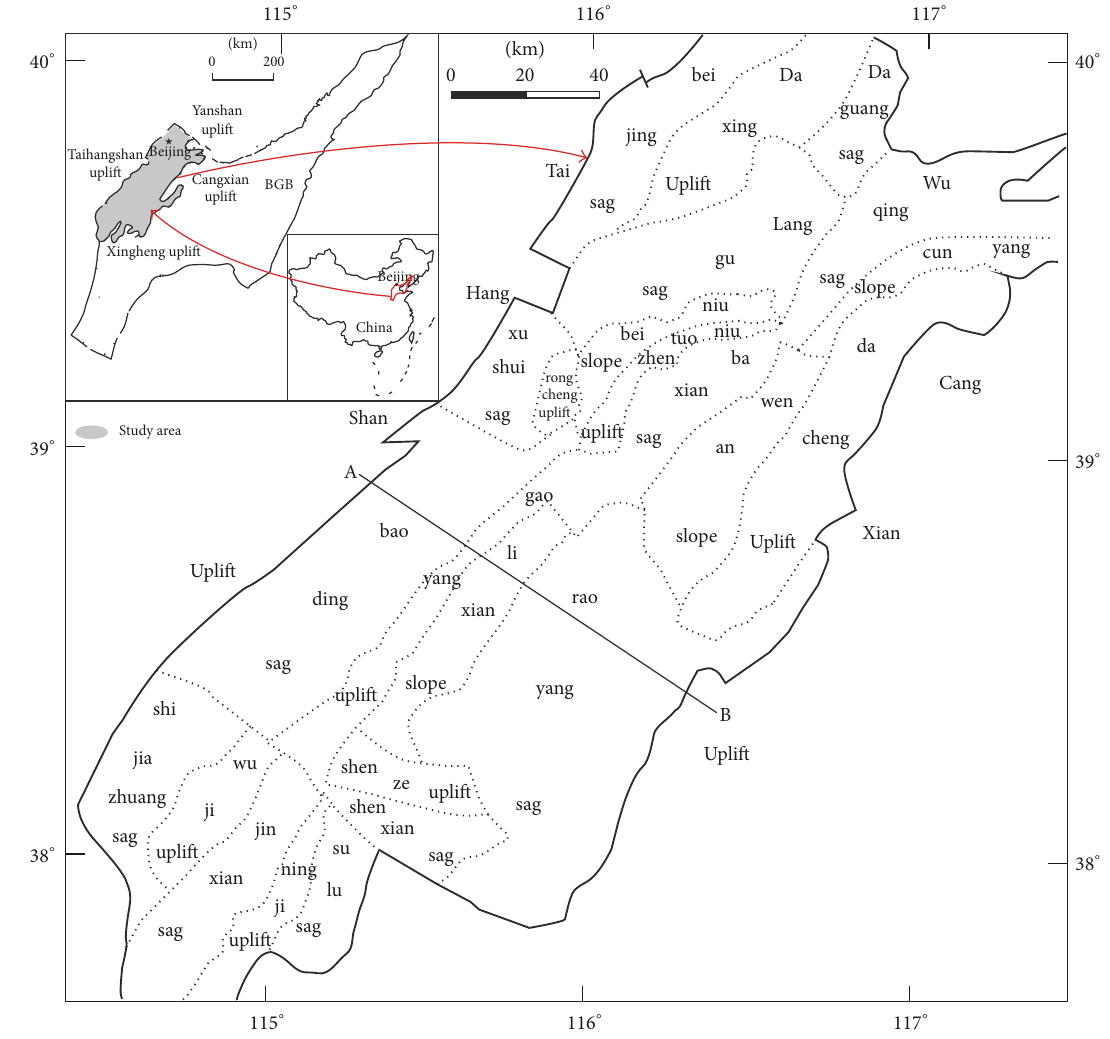
Figure 1: Sketch map showing location and structure of the Jizhong Depression.